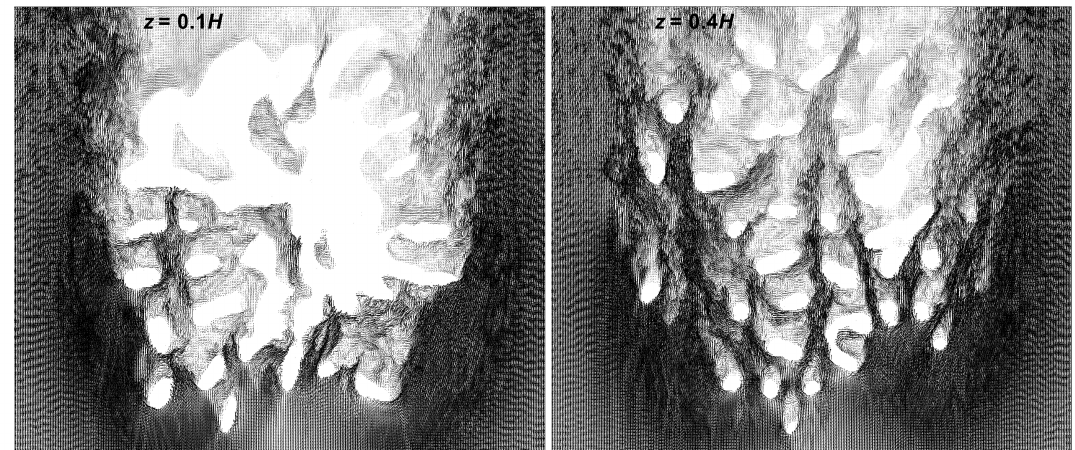
Figure 6. Top view of the instantaneous velocity vector fields at two different heights ( z = 0.1 H and 0.4 H , where H is the height of the colony) inside the P. eydouxi colony. In comparison to P. meandrina , the velocity vector field demonstrates relatively higher flow penetration into the P. eydouxi colony because of the openness of the structure. The formation of wakes can be observed behind individual branches.